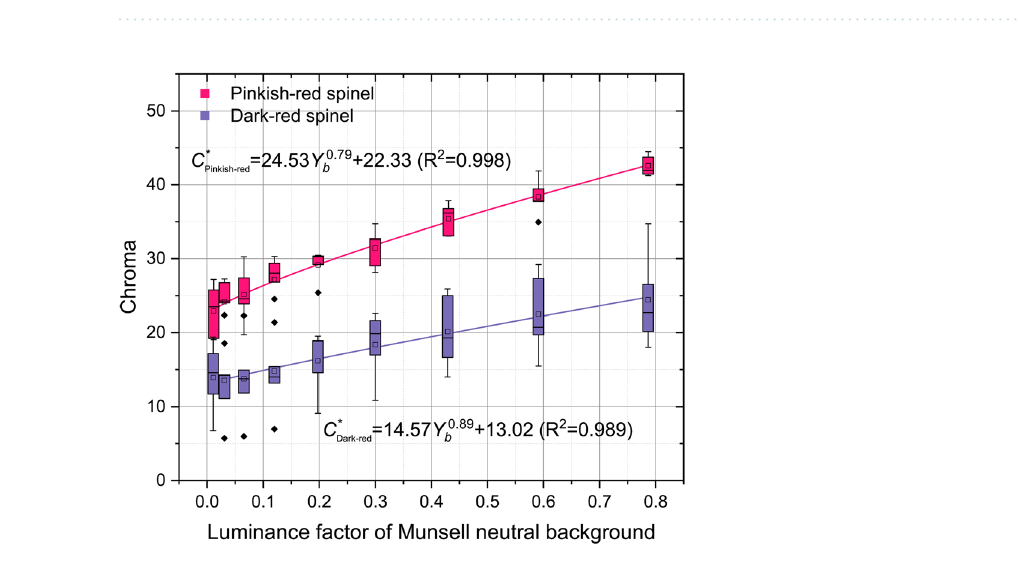
Figure 7. The lightness of spinel increases with the luminance factor ( Y b ) of the Munsell neutral background in the power function.